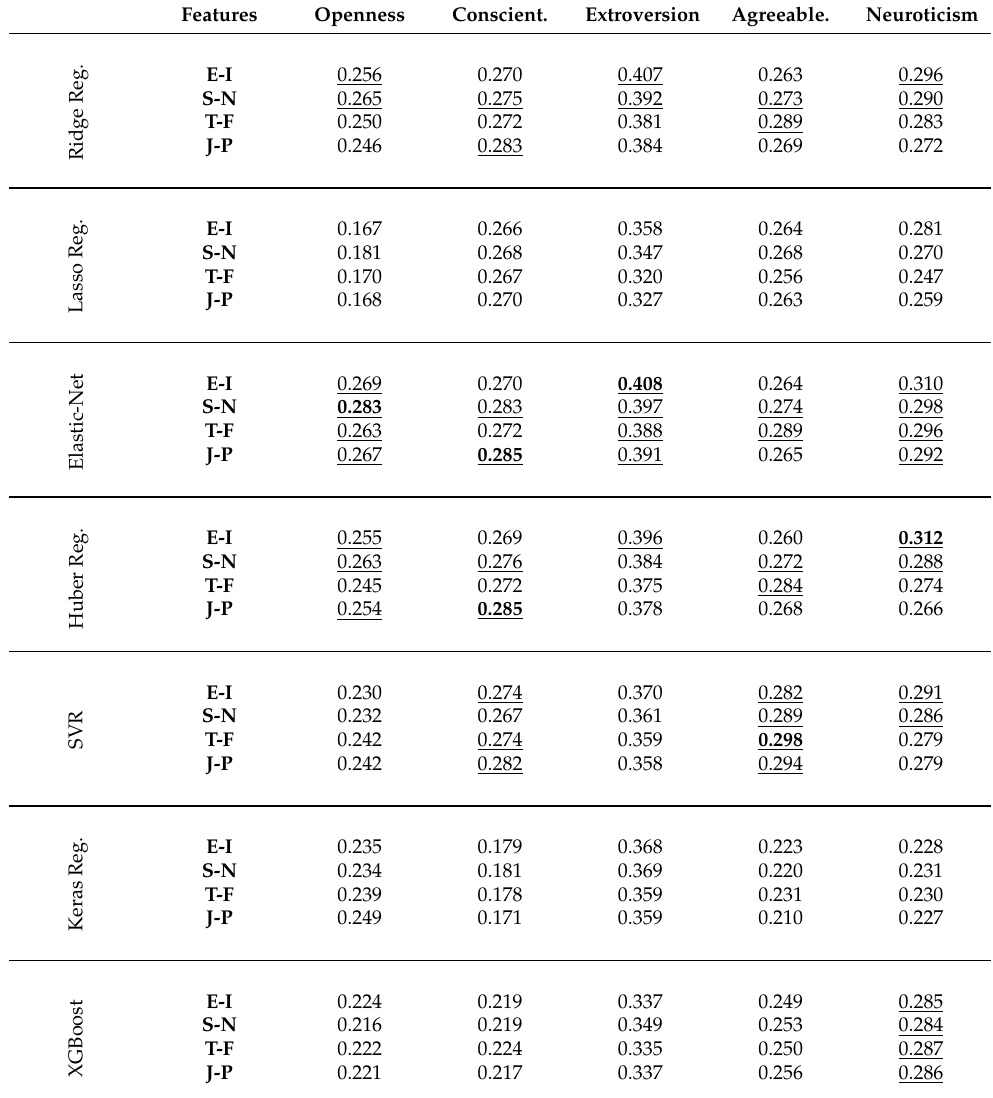
Table 17. Scores for predicting the gold-standard Big Five labels using combinations of n -grams, MBTI/Enneagram predictions and LIWC dimensions selected through process outlined in the previ- ous subsection (Table 14) evaluated on different models. Features Openness Conscient. Extroversion Agreeable.